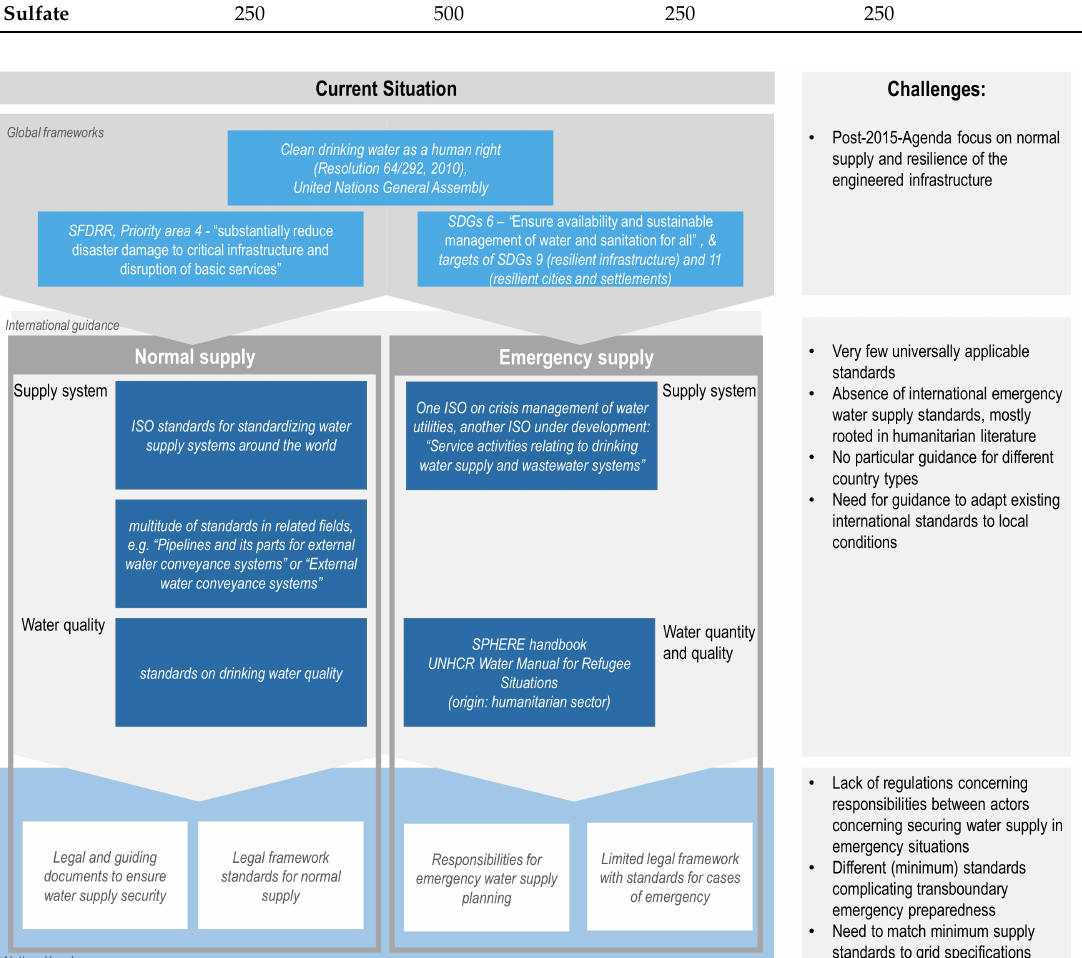
Figure 1. Summary of the findings of this